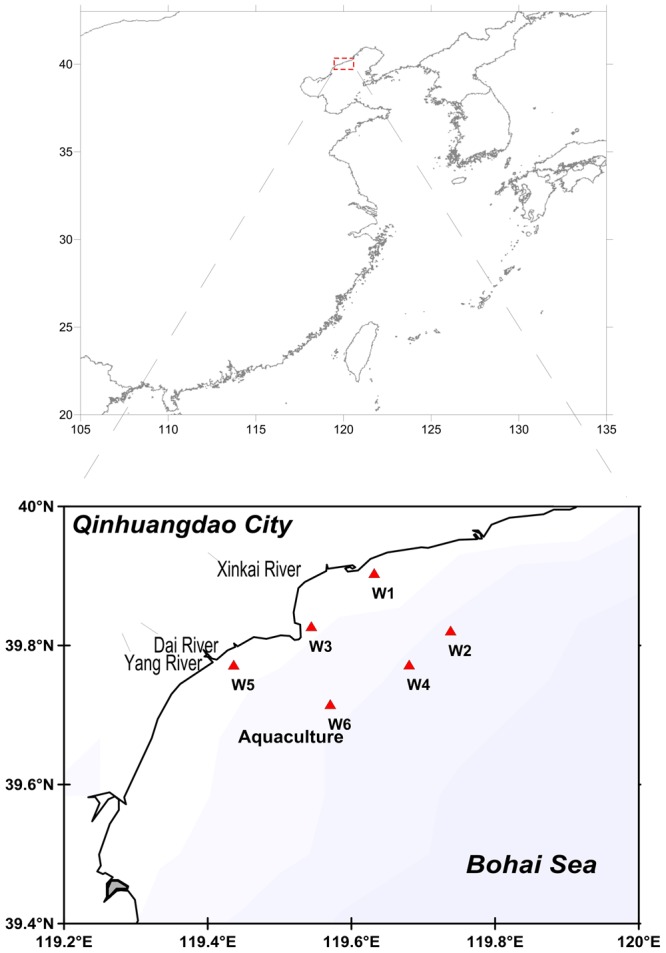
Map of sampling stations.